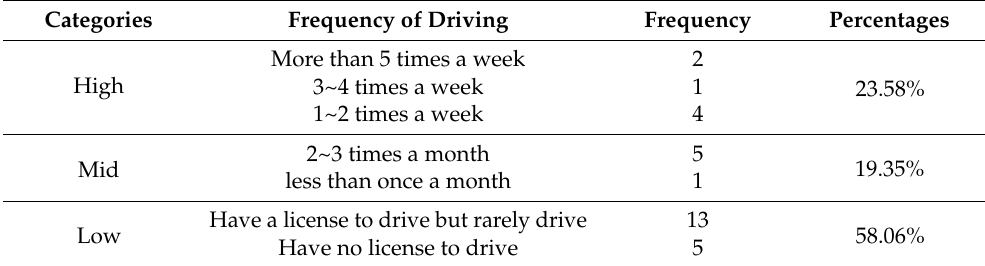
Table 1. Participants’ frequency of driving ( n =